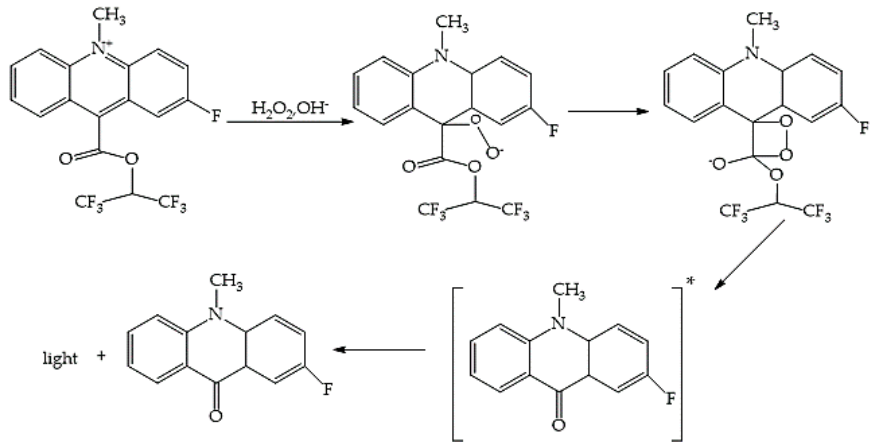
Figure 4. Mechanism for the chemiluminescence reactions of chemiluminescent reductive acridinium triggering (CRAT) assay